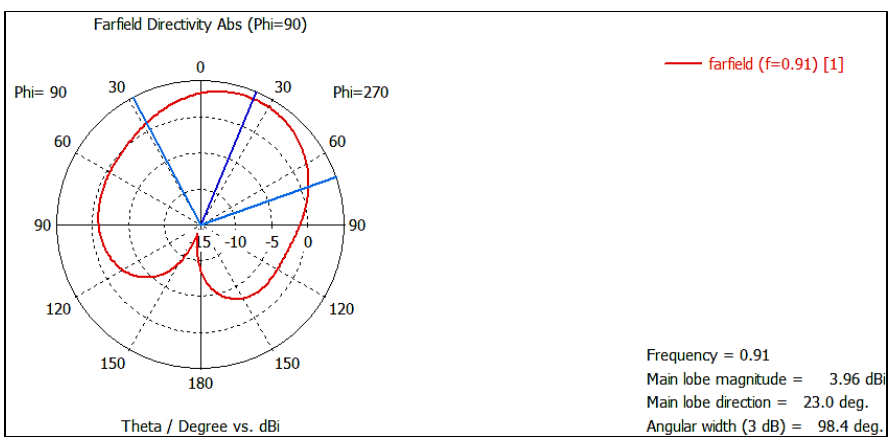
Figure 13. Antenna pattern at first frequency ( 𝑷𝒉𝒊 = 𝟗𝟎